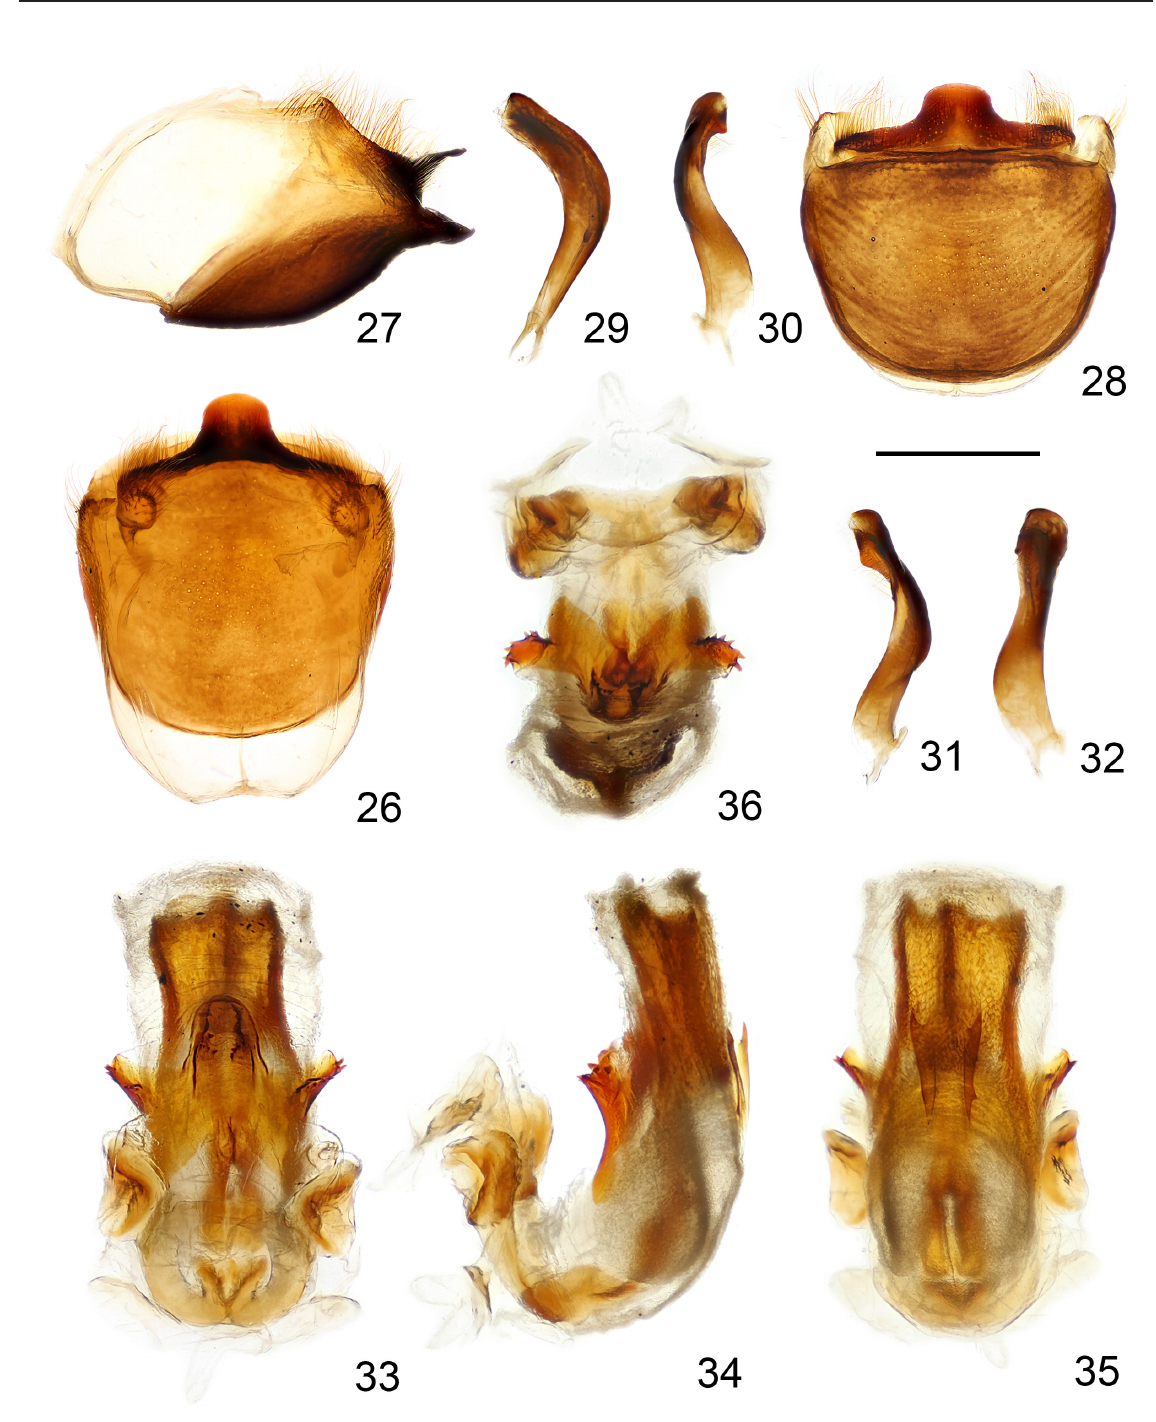
Figs 26–36. Xenorhyncocoris attractivus sp. nov., paratype, ♂ (CAU-RE-0000006). 26 . Pygophore, dorsal view. 27 . Same, lateral view. 28 . Same, caudal view. 29–32 . Paramere. 33 . Phallus, dorsal view. 34 . Same, lateral view. 35 . Same, ventral view. 36 . Same, front view. Scale bar: 26–32 = 1.00 mm; 33–36 = 0.75